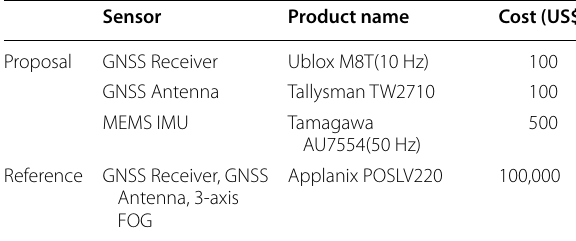
Table 1 Equipment used for